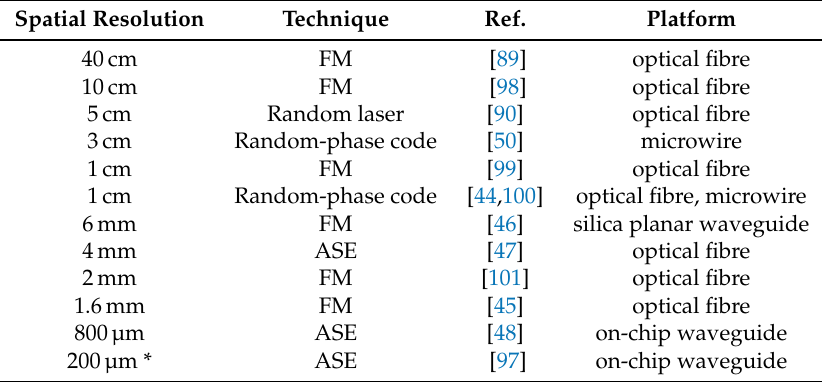
Table 1. Spatial resolution achievements in BOCDA techniques with a focus on mm- and sub-mm- scale